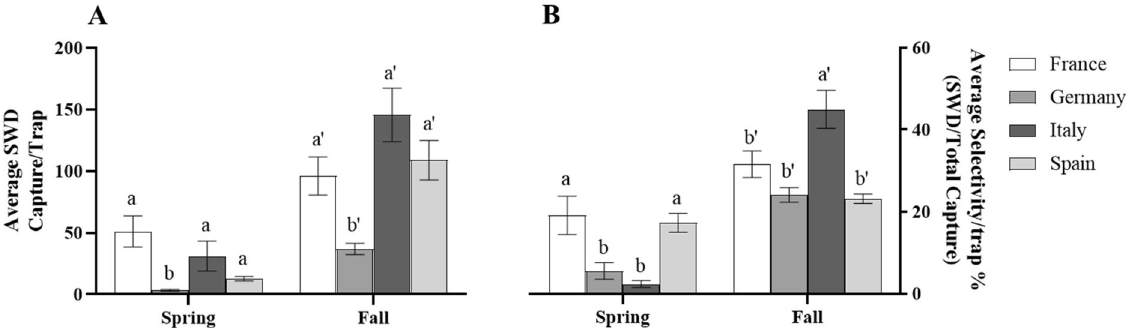
Figure 3. Average capture ( A ) and average selectivity ( B ) per trap of QB baited dry sticky trap systems during the spring and fall within France, Germany, Italy, and Spain. Bars represent standard error of the mean. Means separated by One-way ANOVA with a Tukey’s post hoc test. Different letters above bars (within season) indicate significant differences (α = 0.05). Data represented are